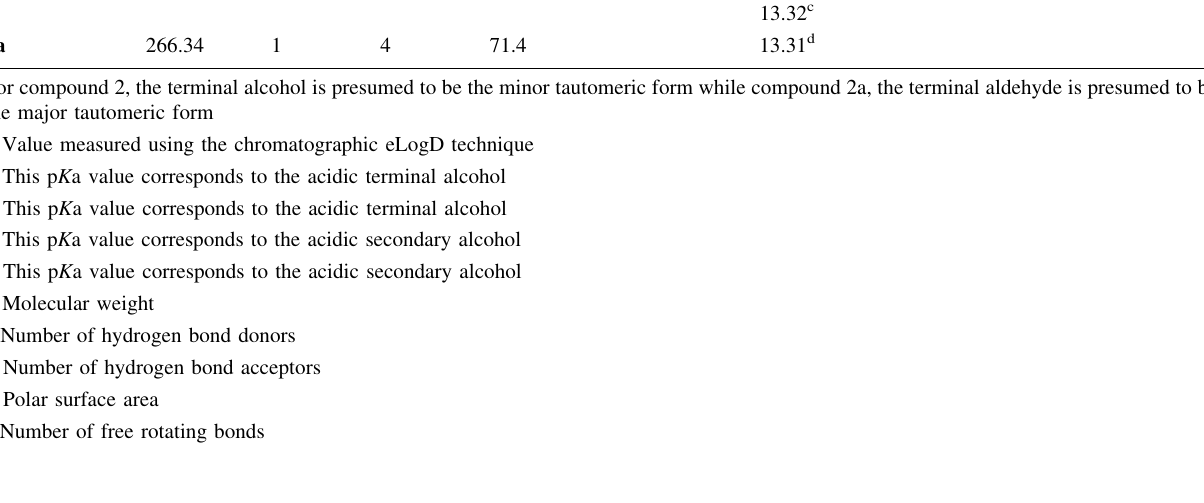
Table 6 Calculated metabolic parameters for compounds 1 and 2 based on NADPH dependent degradation profiles in human liver microsomes